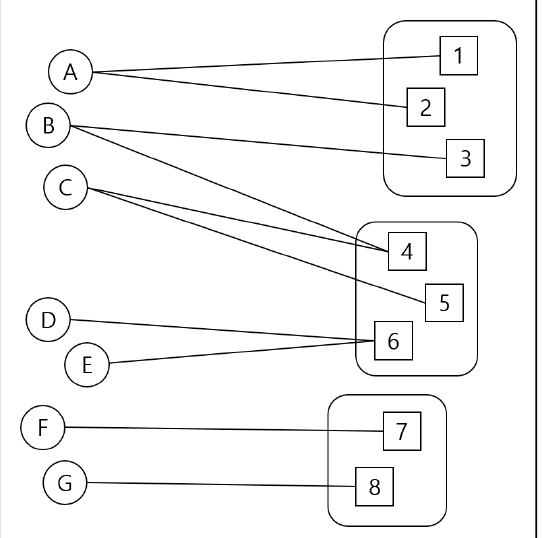
Figure 1. Illustrative figure to demonstrate the relationships between top-level domains and health authorities across countries. Note: This illustration was adapted from Shumate et al. [28] The existence of a tie indicates the number of web mentions from a particular top-level domain to a particular country’s official COVID-19 website. The circles with letters on the left indicate the top-level domains that cited government health agencies, while the squares with numbers on the right indicate the government health agencies’ websites. The lines between the circles and squares indicate the ties between a top-level domain and the websites of the health authorities in 148 countries, in terms of web mentions. Health authorities’ websites with the same rounded shape were in the same geographic